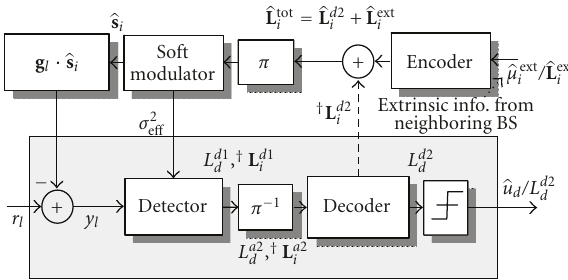
Figure 2: A DID receiver at the l th base station. The subscripts d and i represent the desired data stream and the dominant interferers. Variables designated by † are evaluated only in the first pass of the processing through the receiver. The superscripts 1 and 2 correspond to variables associated with detector and decoder,